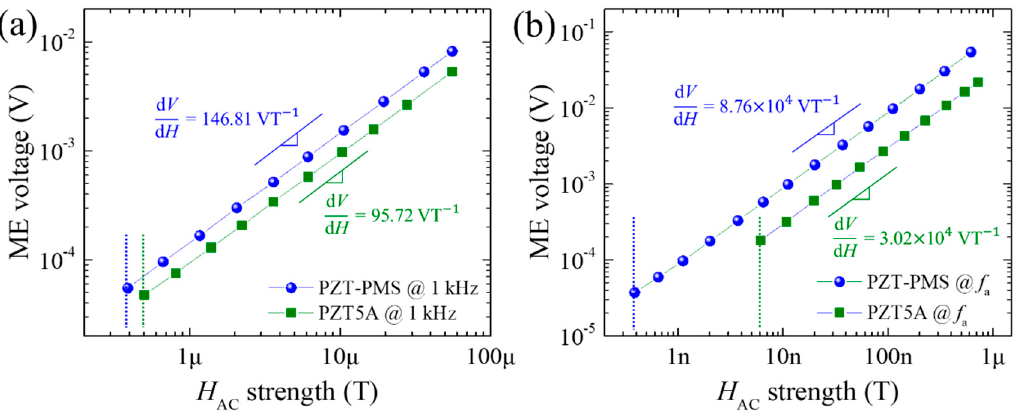
Figure 4. Magnetoelectric voltage output as a function of H AC of PZT-PMS and PZT5A sensors (FE dimensions: 13.5 mm ( l ) × 3.0 mm ( w ) × 1.0 mm ( t )): ( a ) measured at 1 kHz and ( b ) measured at an anti-resonance frequency of the sensors. Slope values and dashed lines indicate magnetic field sensitivities and observed sensing limits, respectively.